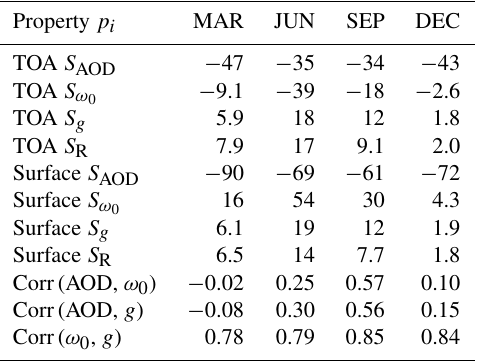
Table 3. Sensitivity of top-of-atmosphere (TOA) and surface DRE to AOD, ω 0 , g , and R . Sensitivities S i are calculated as the slope of DRE versus ρ i , curve, evaluated at base case values (Table 1). All sensitivities are in units of Wm − 2 per unit change in the parame- ter ρ i . The correlations between aerosol optical properties are used along with uncertainties (Table 2) to calculate the covariances used in the DRE uncertainty calculations (Tables 4 and